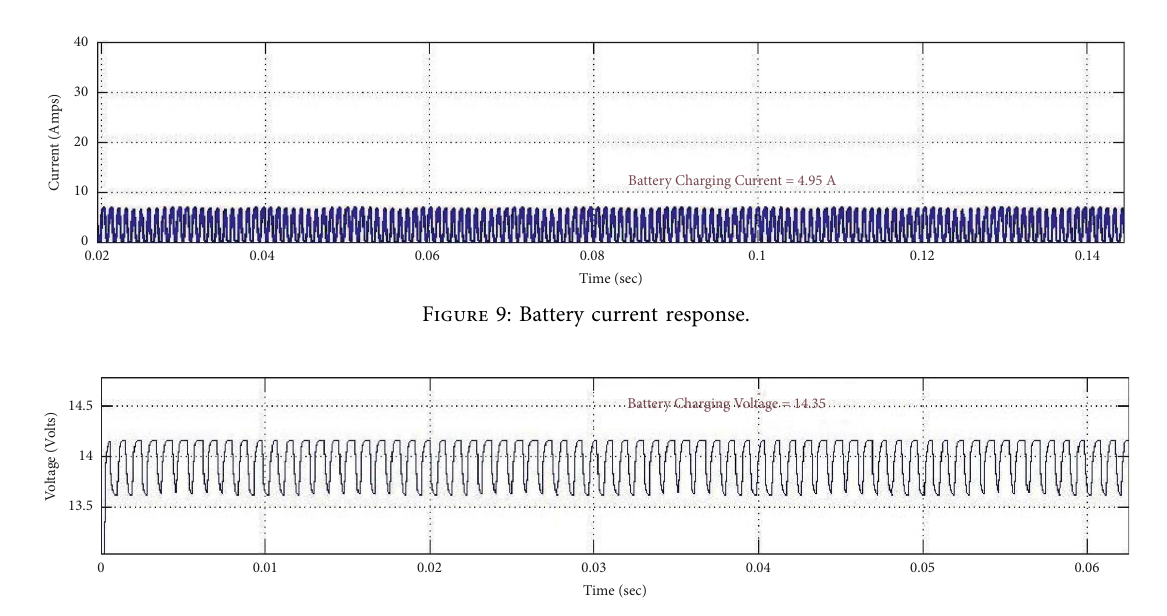
Figure 8: Battery voltage response.